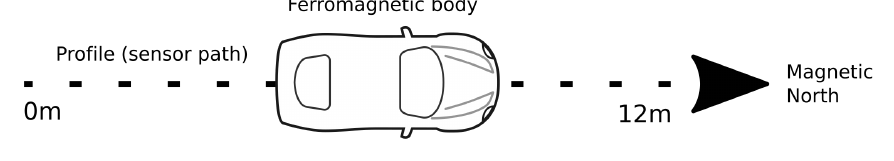
Figure 11. Profile used for testing a basic survey with the drone magnetometer.